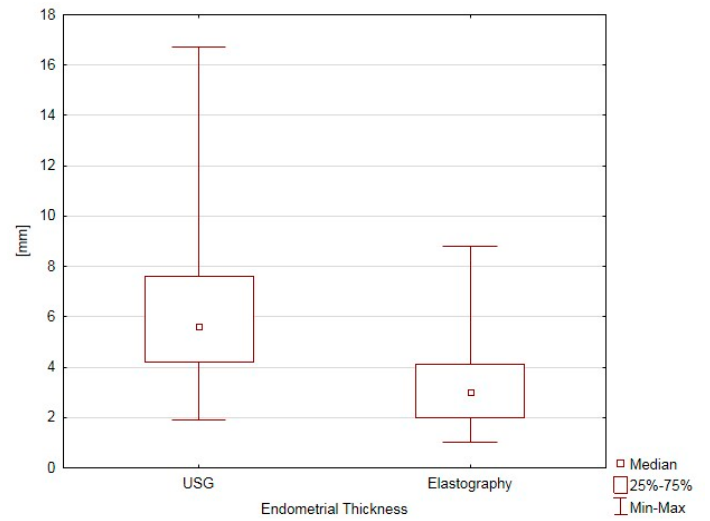
Figure 3. Comparison of endometrial thickness (ET) in ultrasound examination and thickness of the softest endometrial layer in elastography (TEE).